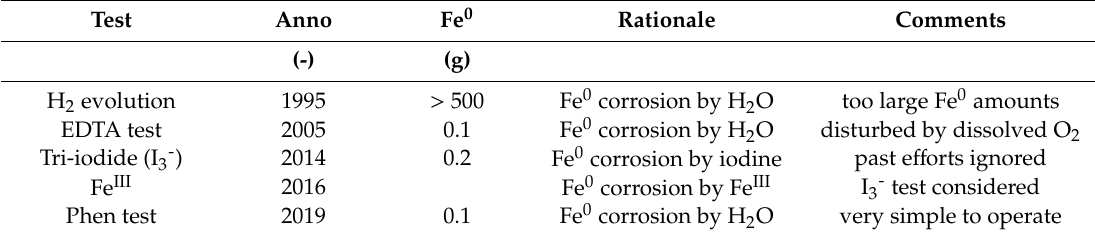
Table 1. Overview of the available contaminant-independent approaches to characterize the intrinsic reactivity of Fe 0 materials. In this study, intrinsic reactivity is characterized by the initial dissolution kinetics of tested Fe 0 in EDTA and